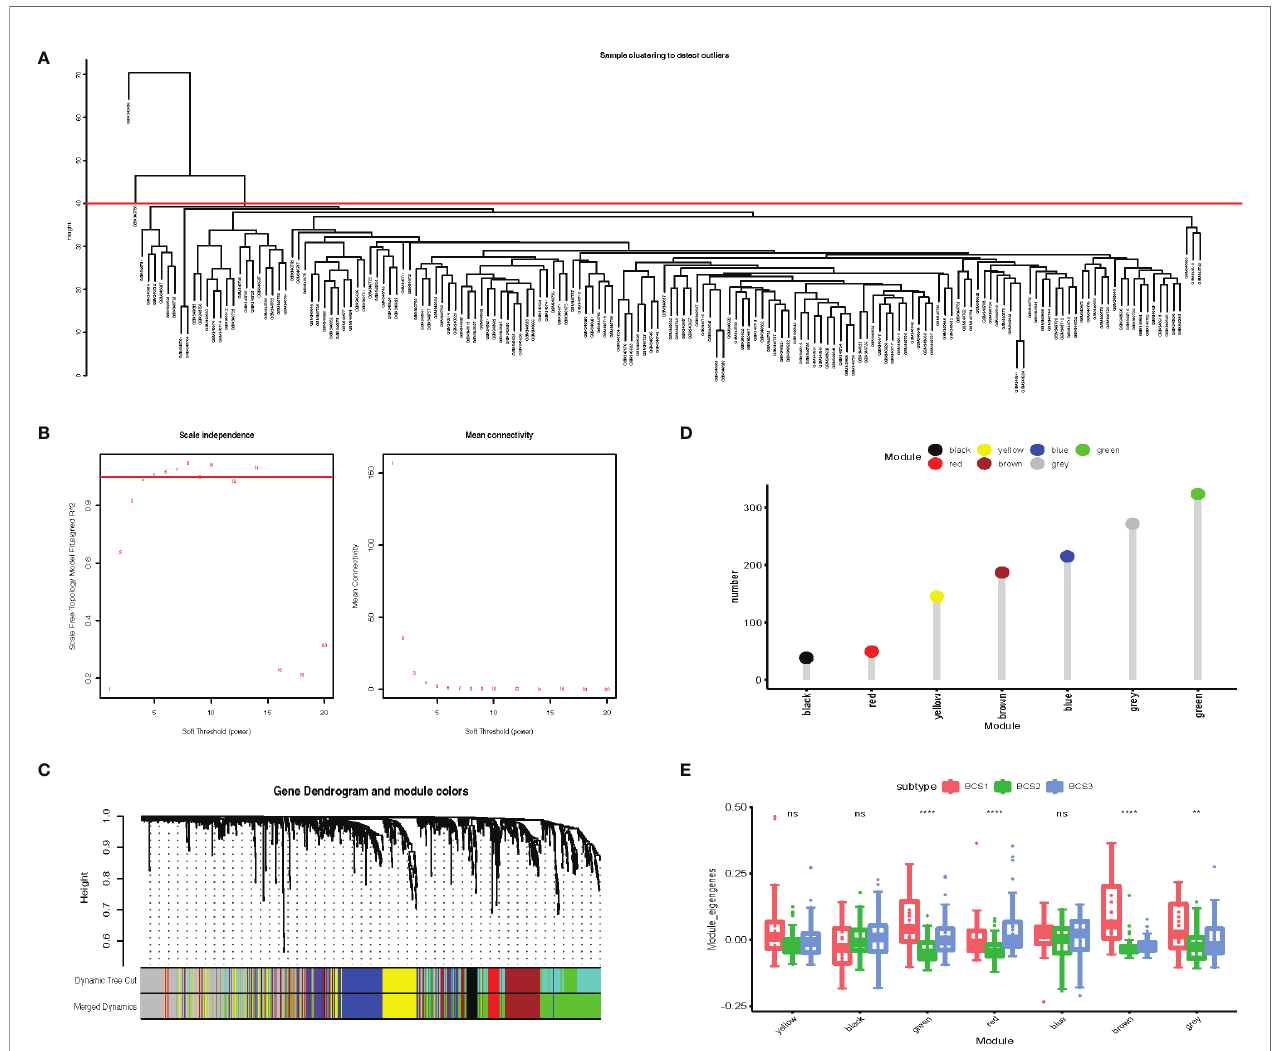
FIGURE 9 | Identi fi cation of critical immune-related gene modules. (A) Sample clustering. (B) Scale-free fi t index for various soft-thresholding powers. Mean connectivity for various soft-thresholding powers (C) Dendrogram of all differentially expressed genes clustered based on dissimilarity measure (1-TOM). (D) Gene numbers in each module. (E) Differential distribution of feature vectors of each module in the BLCA subtypes. ** P < 0.01, **** P <0.0001, and ‘ ns ’ represents not signi fi